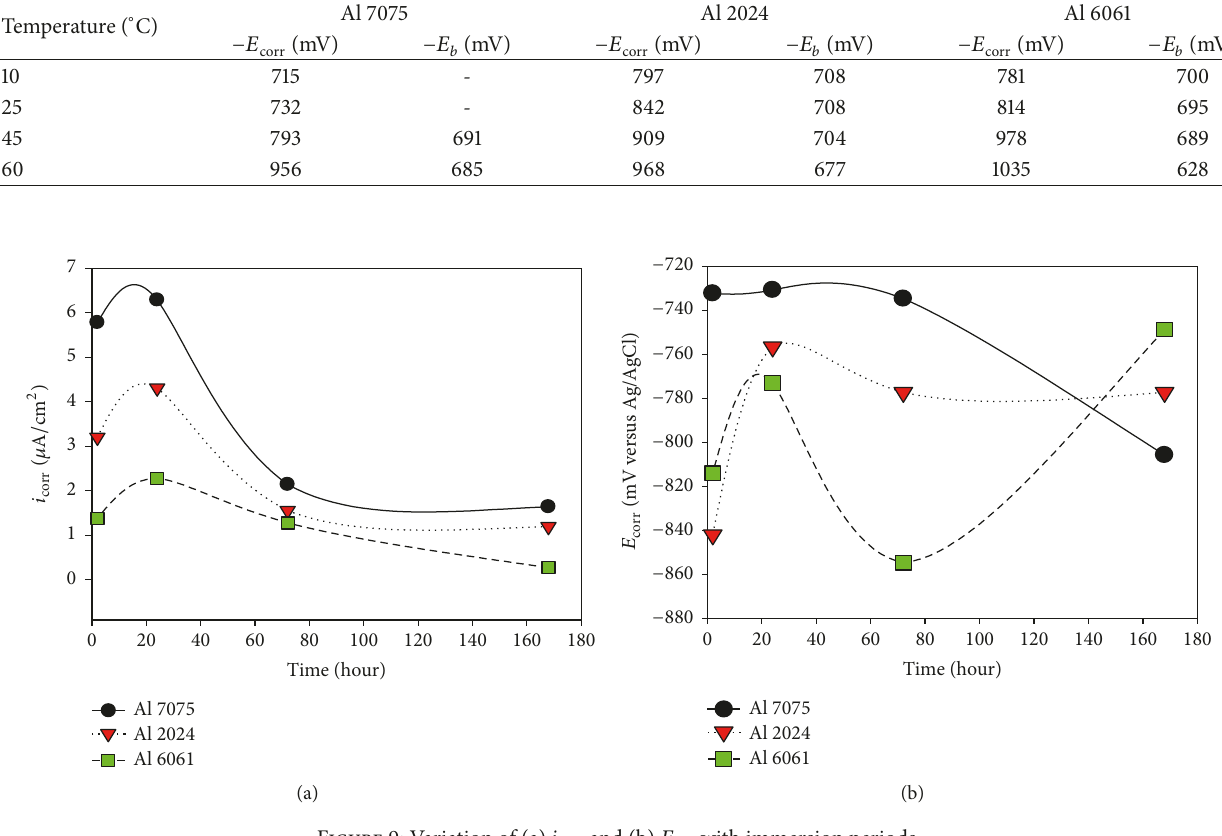
Figure 9: Variation of (a) 𝑖 corr and (b) 𝐸 corr with immersion